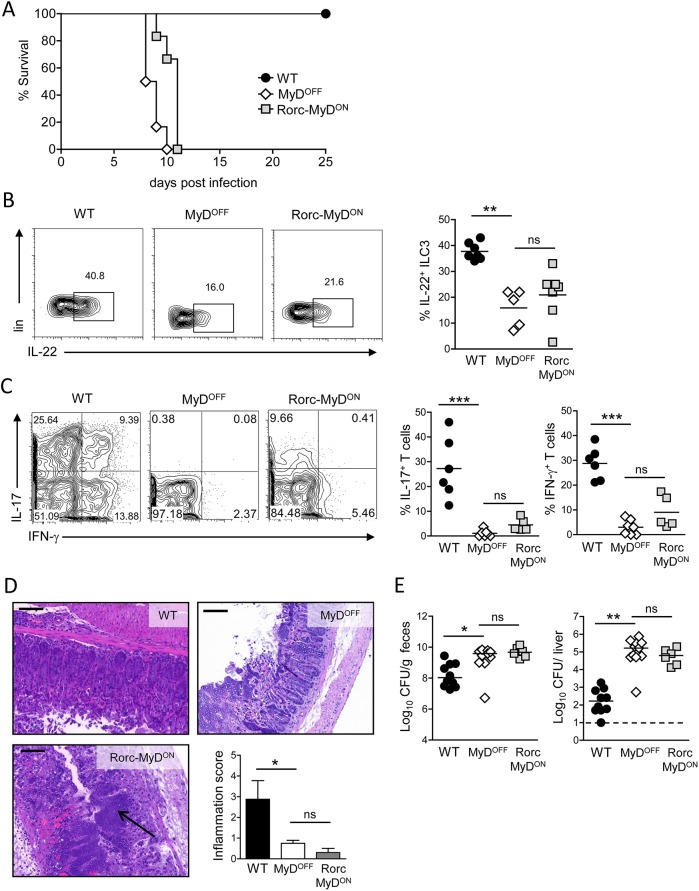
MyD88 signaling in T cells and ILC3 is not sufficient to induce host immune responses.(A) WT, MyDOFF and Rorc-MyDON mice were infected orally with C. rodentium and monitored for survival. (B) Representative flow cytometry plots showing the frequency of colonic IL-22+ cells within live ILC3 on day 4 p.i. Graphs represent frequency (%) of IL-22+ cells amongst live ILC3. (C) Colonic T cell response on day 8 p.i. Representative flow cytometry plots of live CD3+CD4+ T isolated from the cLP and stained for IL-17A and IFN-γ. Graphs represent frequency (%) of colonic IL-17A+ (IFN-γ+/) and IFN-γ+ (IL-17+/−) cells amongst live CD3+CD4+ T cells. (D) Representative H&E staining of colon sections of WT, MyDOFF and Rorc-MyDON mice on day 8 p.i. with C. rodentium. Scale bar represents 100 μm. Black arrow head indicates distinct necrotic epithelial injury and gangrenous mucosal damage in the colon of Rorc-MyDON mice. Bar graph shows inflammation score based on infiltration and epithelial hyperplasia. (E) Bacterial load in the feces and the liver on day 8 p.i. Data are representative for two independent experiments with n = 6 mice per group (A) or were pooled from two (B-D) or three (E) independent experiments with n = 2–5 mice per group. Horizontal bar represents mean. Error bar represents +SEM. Dashed line indicates the limit of detection. One-Way ANOVA with Bonferroni’s Multiple Comparison test; *p<0.05, **p<0.01, ***p<0.001, ns–not significant.